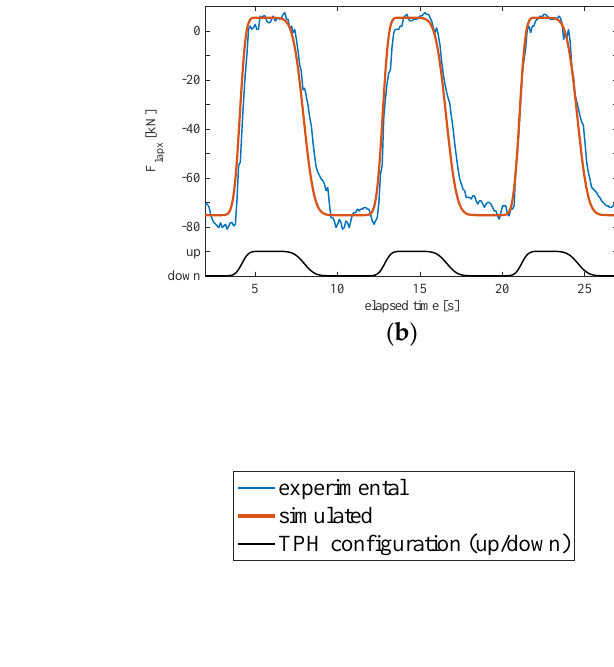
Figure 8. Reconstruction of the hydraulic lift cylinders extension during three manoeuvre repetitions.